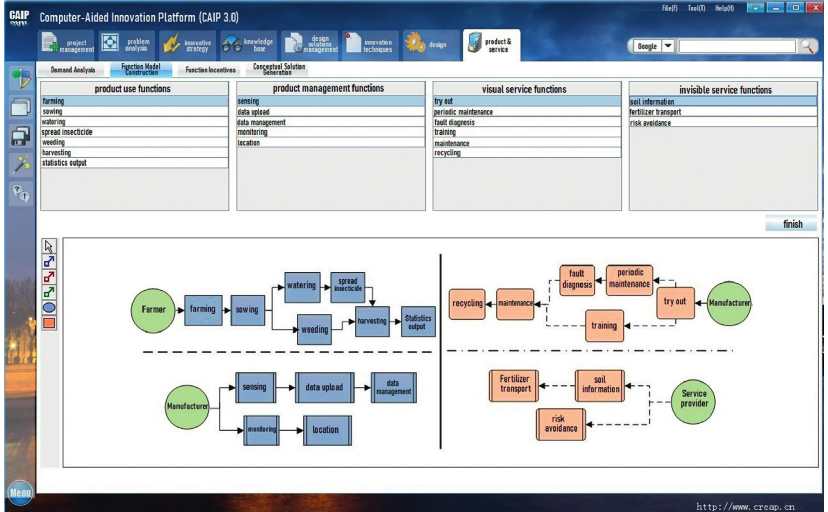
Figure 5: Function blueprint submodule of the agricultural machinery PSS based on CAIP